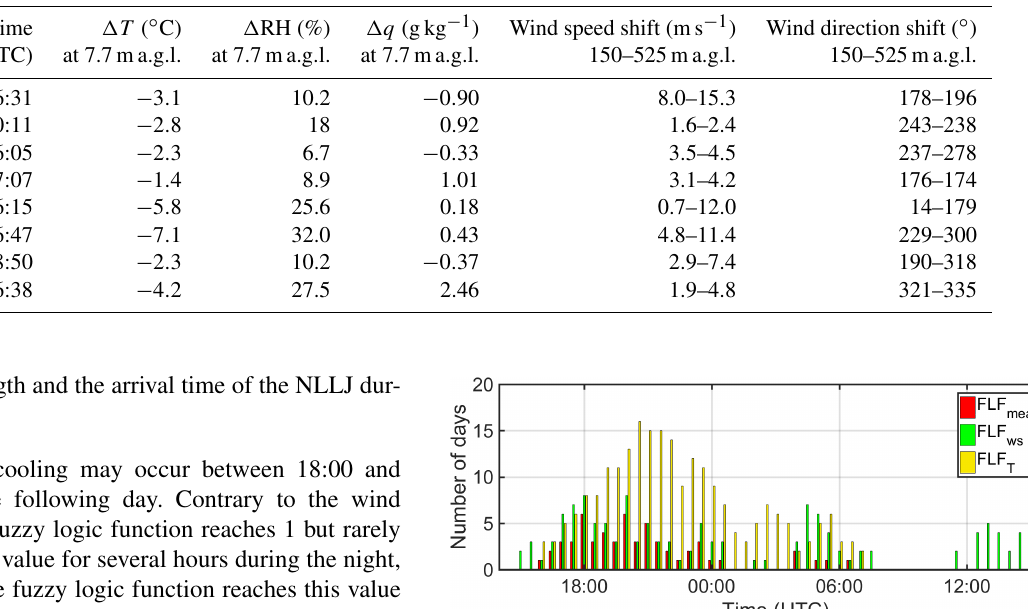
Table 2. Variations in surface (7.77m height) temperature ( (cid:49)T ), relative humidity ( (cid:49) RH), specific humidity ( (cid:49)q ), wind speed, and wind direction outflows that can disturb the MI arrival time and NLLJ onset and participate in the cooling of the atmosphere detected after 15:00UTC. For the wind changes, the wind speed and wind direction averaged within the layer (150–525m) before and after the event are considered.